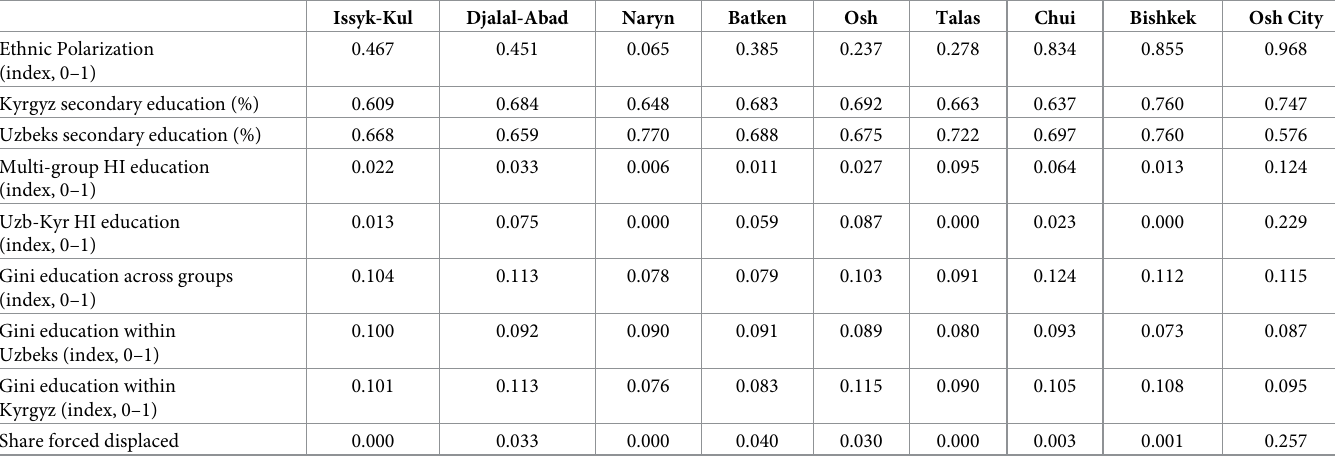
Table 2. Summary statistics across